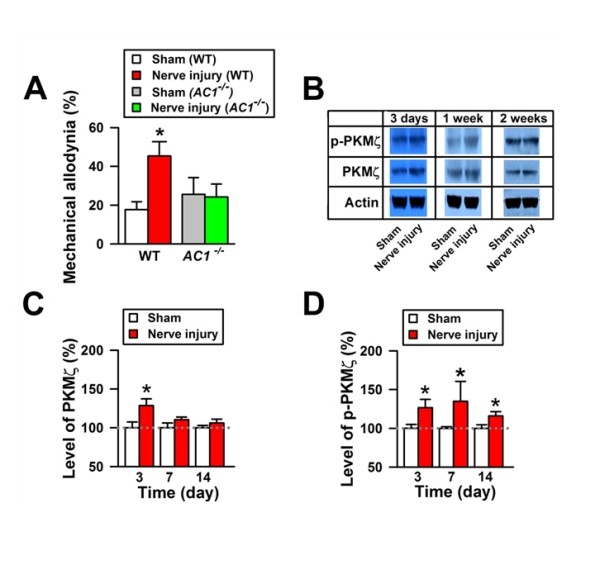
Expression and phosphorylation of PKMζ in the ACC during neuropathic pain. A, Mechanical allodynia was tested in the sham and nerve injury groups from wild-type (WT) and AC1-/- animals 3 days after nerve injury. * indicates P < 0.05; error bars indicate SEMs. B, Western blots for PKMζ and p-PKMζ in the ACC obtained between 3 days and 2 weeks after nerve injury. (The ACC of mice from the sham and nerve injury groups were used for Western blot analysis 90 min after the allodynia test.) C, Level of PKMζ in the ACC of mice from the sham and nerve injury groups. Level of PKMζ increased significantly 3 days after nerve injury compared with PKMζ in the sham group. D, Level of p-PKMζ increased significantly 3 days after nerve injury. This effect lasted over 2 weeks after nerve injury compared with p-PKMζ in the sham group (from Reference 32).